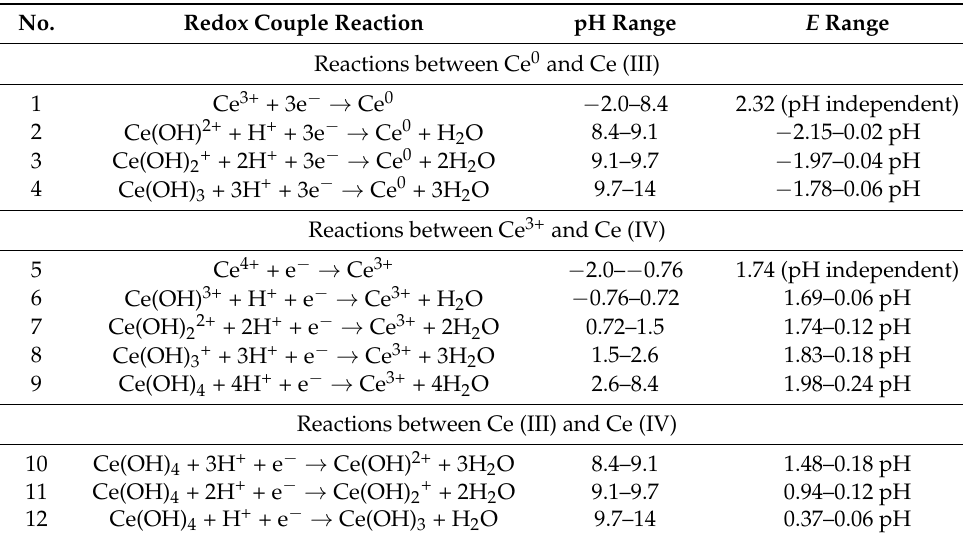
Table 3. Electrochemical potentials required for redox reactions ( E ) for Ce species corresponding to speciation diagrams [43,62–65]